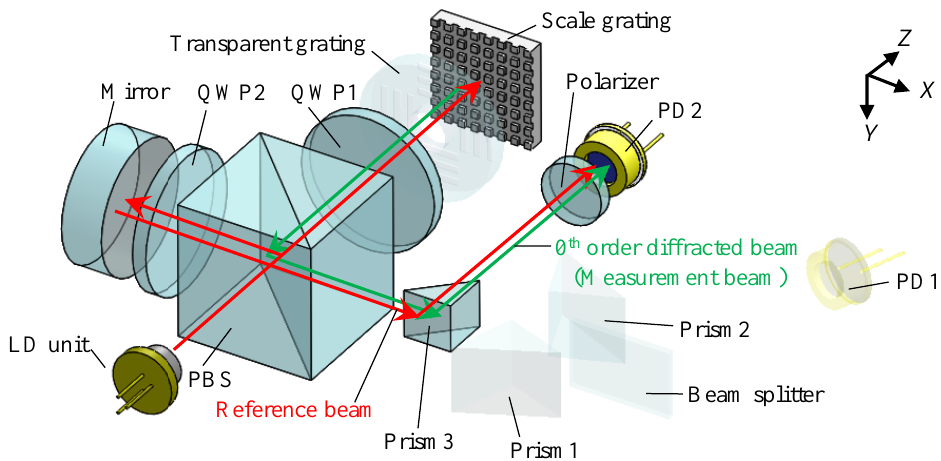
Figure 3. Optical system related to the Z -directional displacement measurement (the transparency of the unrelated components is increased).